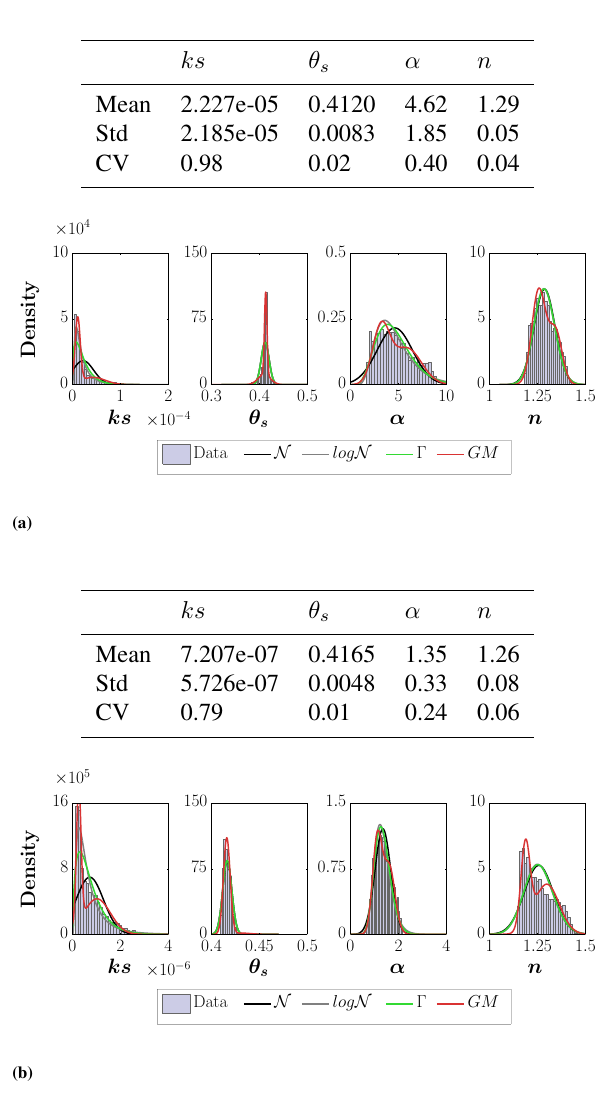
Fig. 12: Prior distribution of the soil hydraulic parameters for the soils SL (a) and SiL (b)